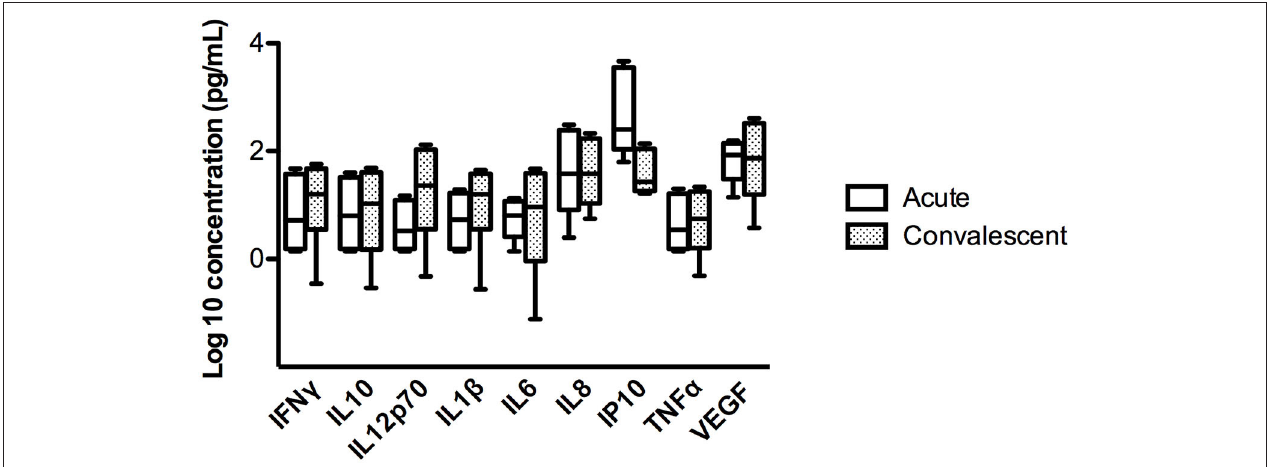
FIGURE 2 | Comparison of concentration of different cytokines in four ANDV-infected cases in acute stage and convalescent stage. Concentrations are represented in pg/mL of INF γ , IL10, IL12p70, IL1 β , IL6, IL8, IP10, TNF α , and VEGF. Clear boxes represent values in acute stage and dark boxes values in convalescent stage; whiskers represent minimum and maximum values and horizontal bars in the box the median value (Wilcoxon rank test, p < 0.05 = significant).